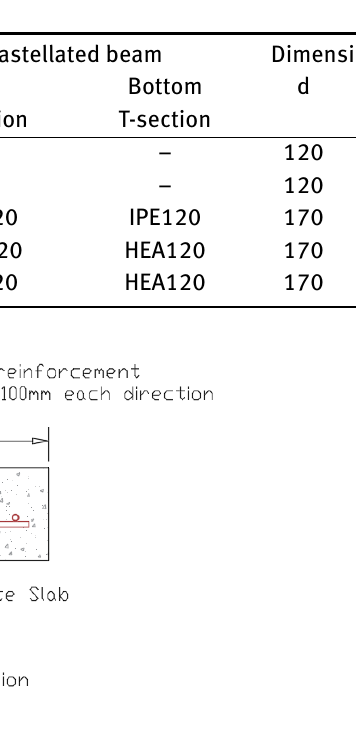
Figure 4: Dimensions of typical concrete flange of composite